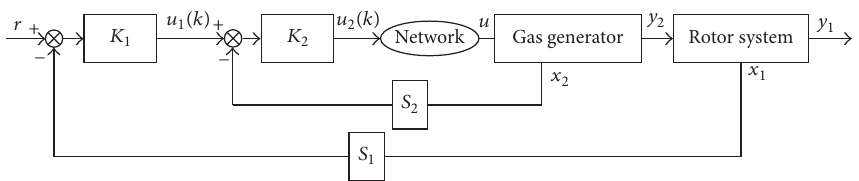
Figure 3: Block diagram of the NCCS